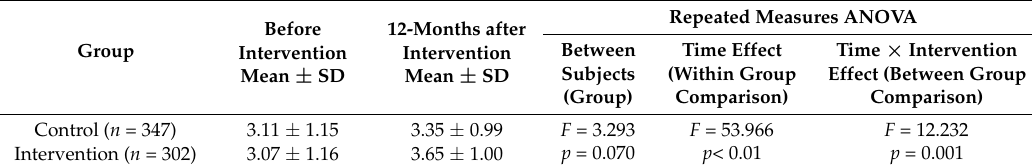
Table 2. Repeated measures ANOVA for intervention and time for knowledge regarding folic acid.